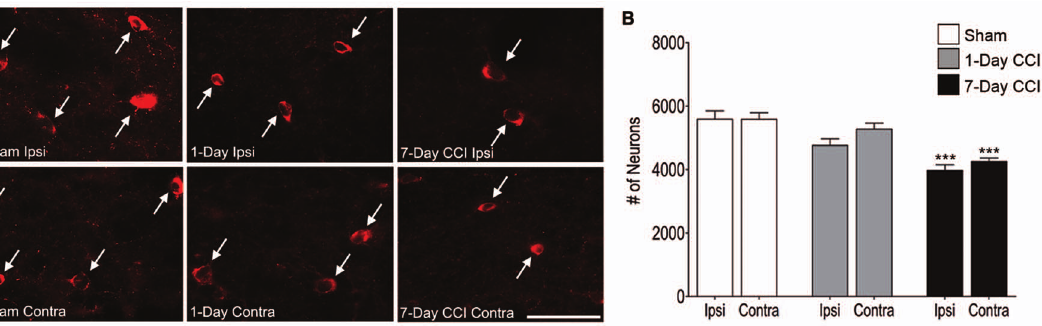
Figure 3. Delayed loss of GABAergic interneurons in the BLA within the first week after mild CCI. (A) Representative photomicrographs of GAD-67 immunohistochemically stained GABAergic interneurons in the BLA of sham (left), 1-day CCI (middle), and 7-day CCI (right) animals. Total magnification is 630x; scale bar, 50 m m. (B) group data showing the mean and standard error of the stereologically estimated total number of GAD- 67-positive cells in the BLA 1- and 7-days after CCI compared with sham. Only 7-days after CCI was there a significant bilateral reduction in GAD-67- positive cells indicating a delayed loss of GABAergic interneurons. ***p , 0.001; n=10 for each group.